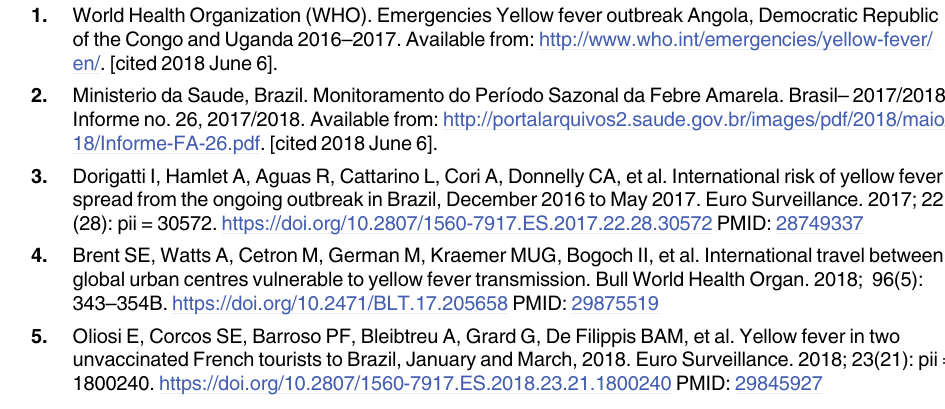
S2 Fig. YF fatal cases. Probability of fatal outcome due to autochthonous YF transmission estimated by the model in 18 sites in Lazio region (Italy), conditional to the introduction of a single imported case at different times of the year and disaggregated by the number of expected deaths. YF, yellow